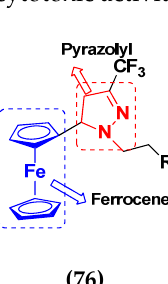
Figure 73. Structure of ferrocene containing a pyrazolyl derivative ( 76 ). Table 62. In vitro cytotoxic activities of ferrocene containing pyrazolyl hybrid compounds 76 ( a – d ). ate their antitumor activity against different cell lines. Most of the synthesized compounds displayed potent anticancer activity. Among them, compound 77 ( a ) exhibited potent ac- Compound No. tivity against three different cell lines, including Tk-10 (renal) UACC-62 (melanoma), and, MCF-7 at IC 50 2.4, 3.0 and 2.5 µ M, respectively. Control parthenolide (PTD)-had IC 50 values of 6.4, 15.0 and 5.8, respectively. The structure of ferrocenyl-chalcone amide derivatives are shown in Figure 74 and the in vitro cytotoxic activities of hybrid compounds 77 ( a – d ) are listed in Table 63